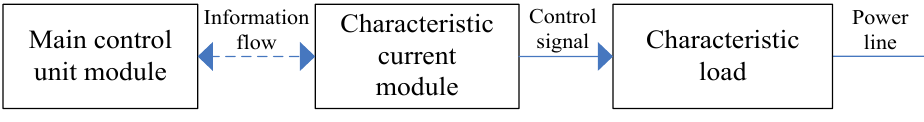
Figure 2. Characteristic current sending process. The current characteristics of topological identification are shown in Figure 3. The switching frequency can be set, with the default being 833.3 Hz, and both high-level and low-level pulse widths can be set. The characteristic current’s carried information can be set, the start symbol is AAH = 10101010C, the control code is E9H = 11101001C and the length of the subsequent extended domain information is variable. Among them, when the code bit is 0, there is no characteristic current transmission, and when the code bit is 1, there is a characteristic current transmission. The length of each bit code’s sending time can be set, and the default is 600 ms ± 15